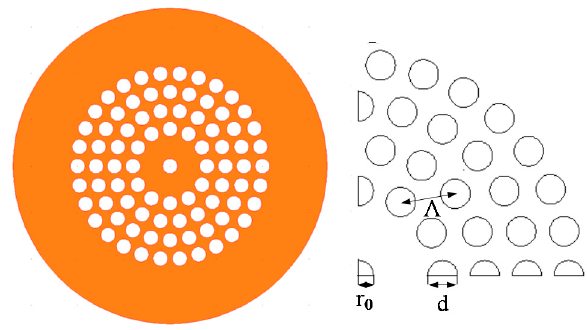
Figure 2. Cross-section and main parameters of C-PCF. Reprinted with permission from [36]. Copyright 2015 Optical Society of America.